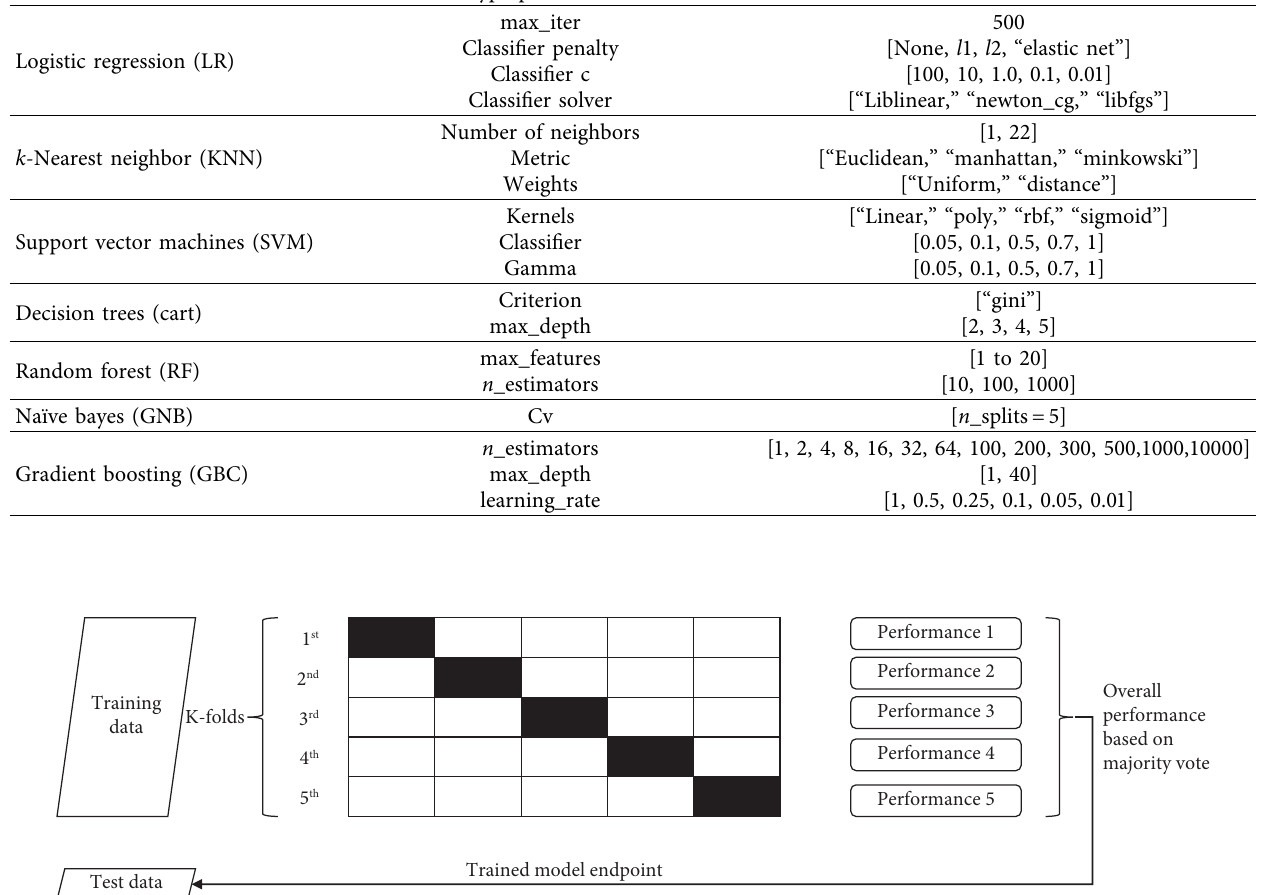
Table 2: Common classifers in machines and equipment failure modelling.